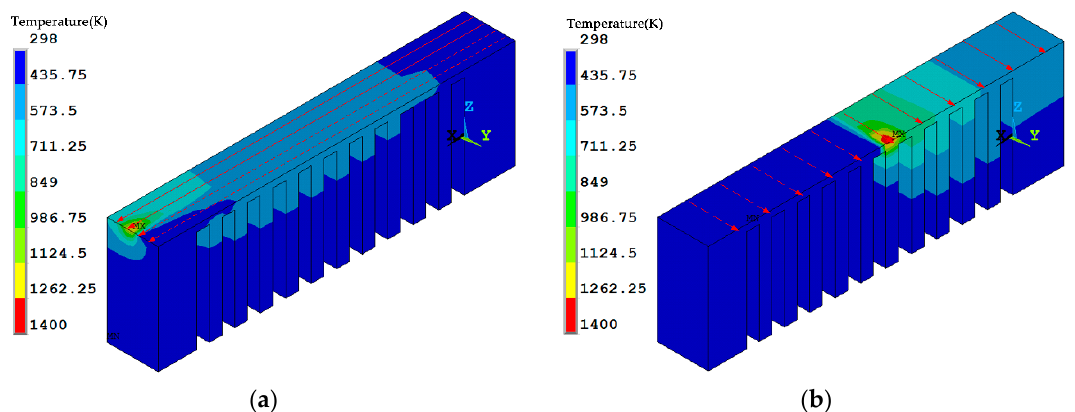
Figure 7. Temperature distribution under different scanning strategies during the printing process (solid vectors are the scanned tracks while the dashed vectors are to become scanned tracks): ( a ) the x scanning route; and, ( b ) the y scanning route.